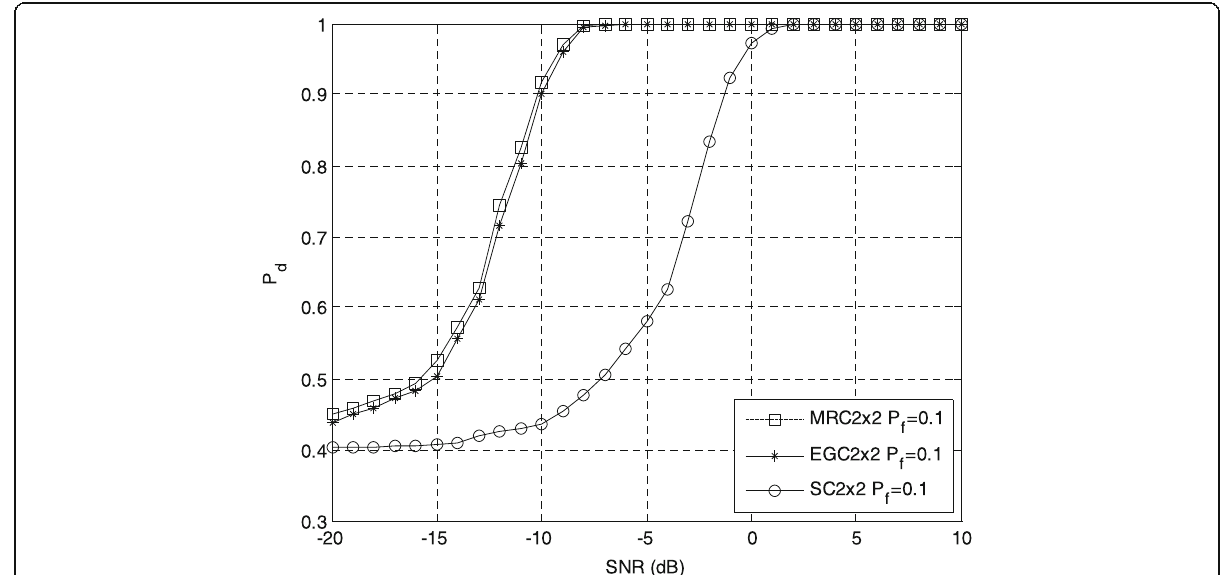
Fig. 6 Performance comparison of the three combining detection methods in 2 × 2 MIMO system